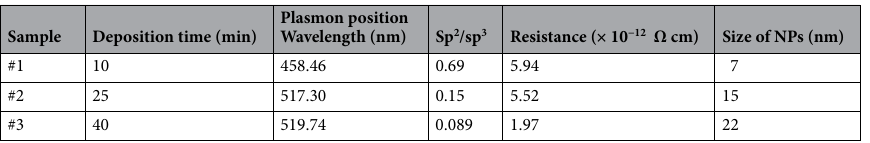
Table 1. Obtained parameters from characterization of